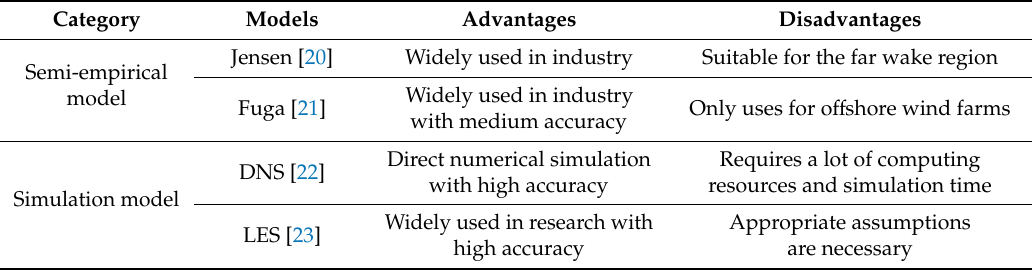
Table 1. The advantages and disadvantages of research on wind turbine wake models.